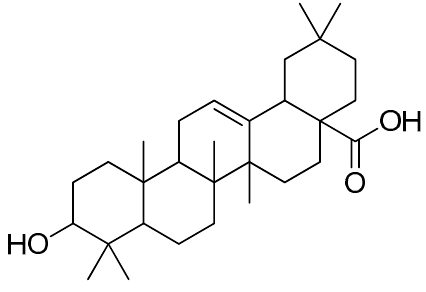
Figure 16. Oleanolic